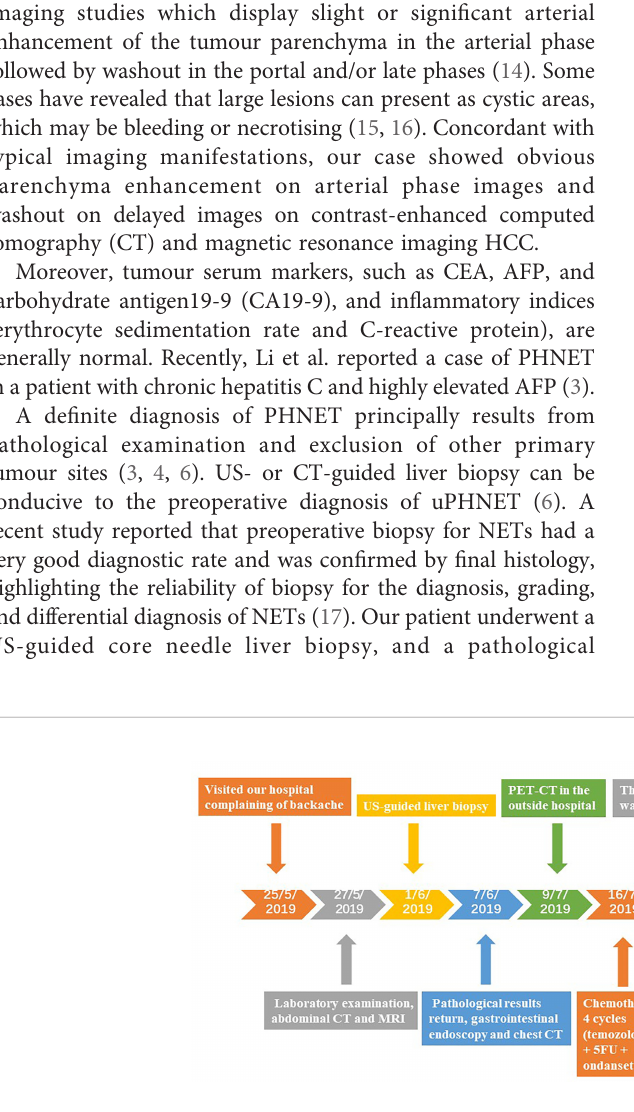
FIGURE 4 | Timeline of the patient ’ s diagnosis and treatments.